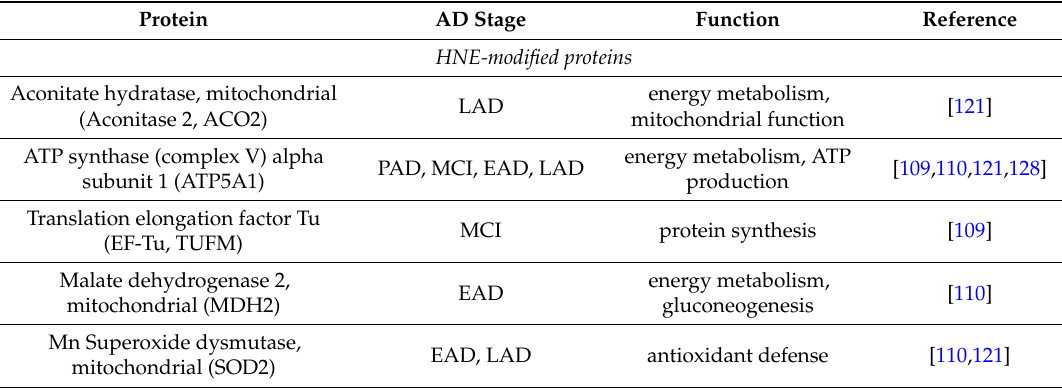
Table 4. Adducts of aldehydes derived from lipid peroxidation with mitochondrial proteins in neurodegenerative diseases, in relation with clinical